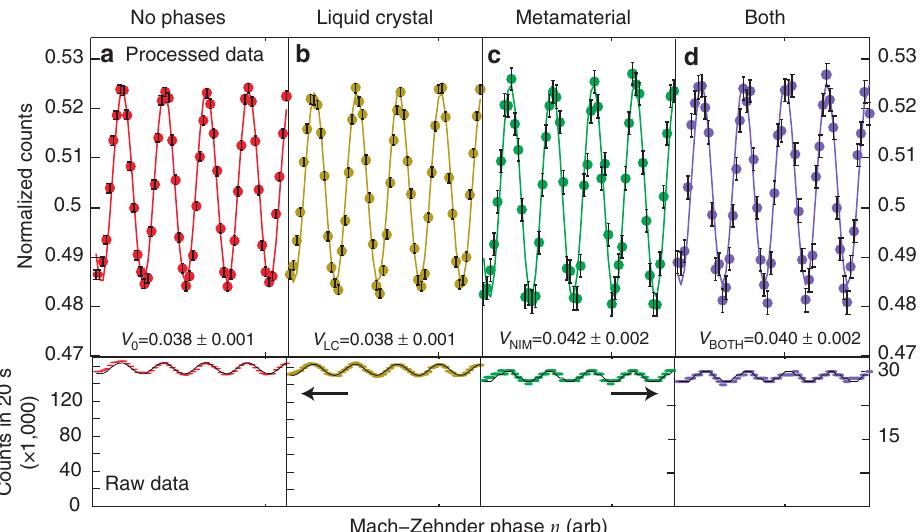
Figure 3 | Representative Interferograms of the Mach–Zehnder Interferometer. All of these data are photon counts exiting one port of the interferometer plotted versus the phase of the Mach–Zehnder interferometer. The data in the upper row are the count rates of photons exiting port one (at D1) normalized to the sum of the counts out our both ports. The lower row shows the same data without normalization. The error bars represent the standard error, arising from Poissonian counting statistics. Measurements for four cases are shown: ( a ) no phases inside of Sagnac loop, ( b ) only a positive phase (using the liquid crystal), ( c ) only a negative phase (using the negative-index metamaterial) and ( d ) both phases engaged. The visibilities of the data shown in c , d are equal within error. The unnormalized data (lower row) presented a , b uses the scale bar on the left, while the unnormalized data of c , d uses the scale bar on the right. The decreased count rate is due to the 13% transmission of the metamaterial.